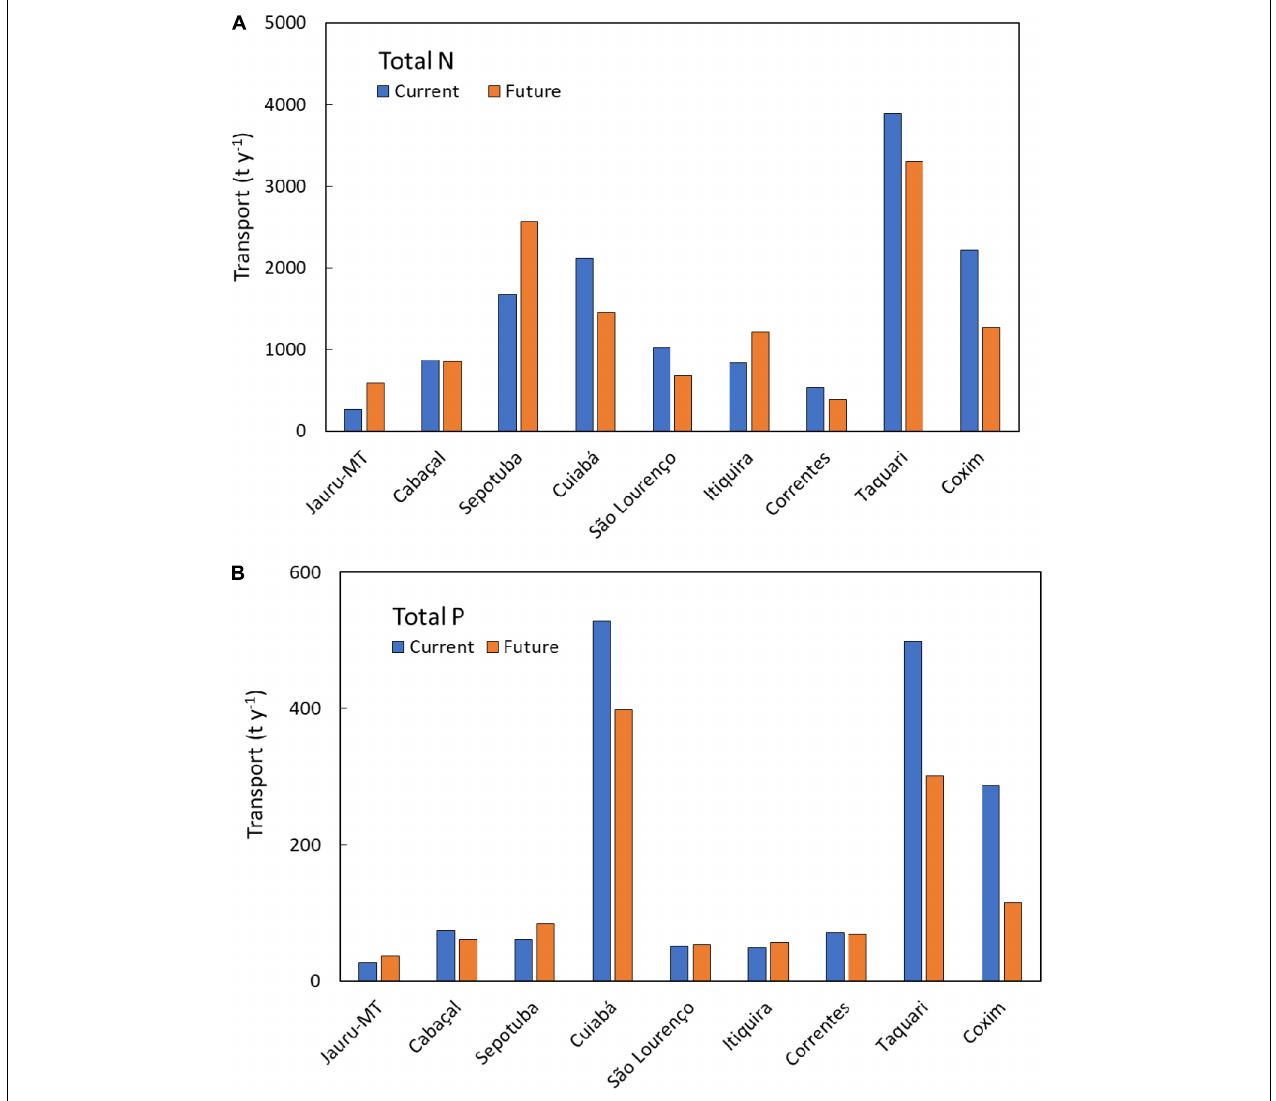
FIGURE 8 | Summary of transport of (A) total nitrogen and (B) total phosphorus by rivers from the upland watershed into the Pantanal. Bars show current rates and rates predicted by the neural network modeling were all future hydropower facilities to be built in each river